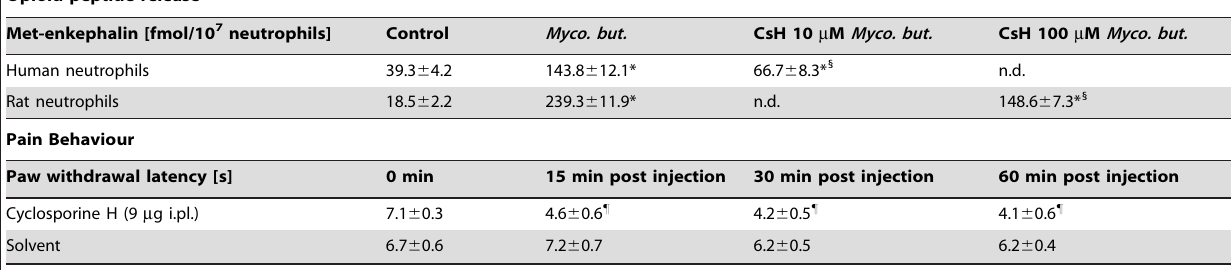
Table 2. Effect of the FPR antagonist cyclosporine H (CsH) on Mycobacterium butyricum -( Myco. but. ) induced Met-enkephalin release from human and rat neutrophils and on nociceptive thresholds in complete Freund’s adjuvans induced hindpaw